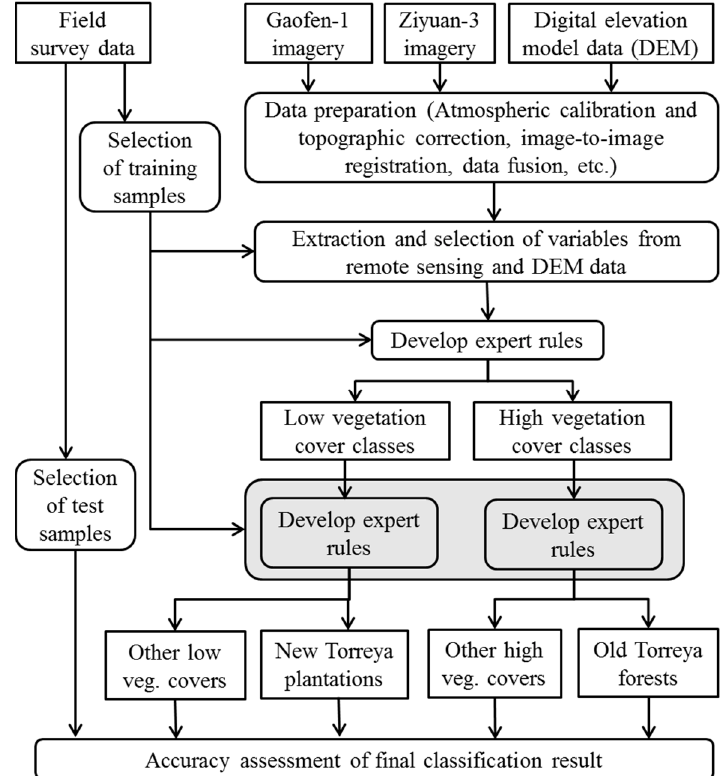
Figure 3. Framework of mapping Torreya forest distribution using high spatial resolution satellite images and ancillary data (Note: veg. represents vegetation).